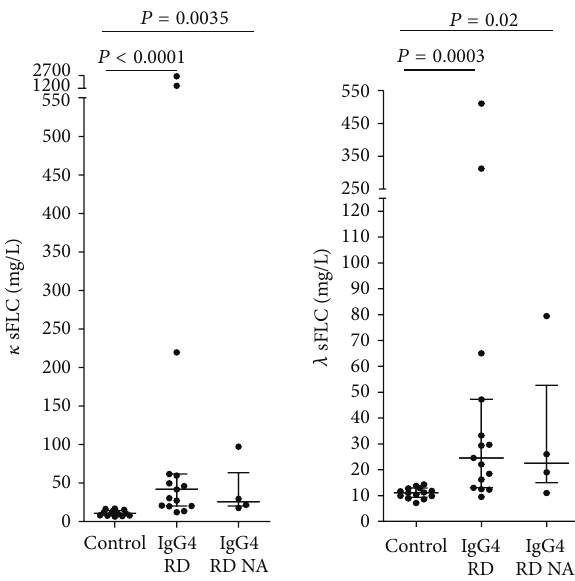
Figure 1: Kappa/lambda serum FLC in patients with IgG4-RD. Comparison of serum-free 𝜅 and 𝜆 light chains in controls, IgG4- RD patients with active disease (IgG4-RD) and nonactive disease (IgG4-RD NA). Median and interquartile ranges are shown.